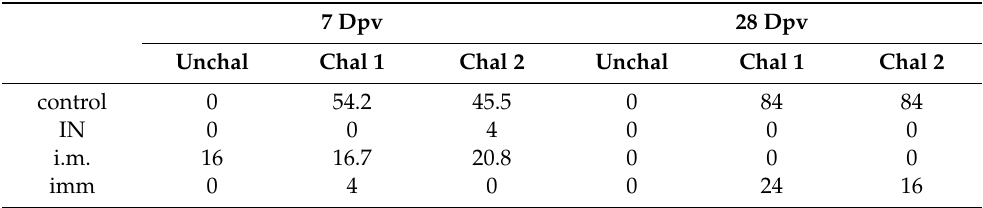
Table 2. Percent (%) cumulative mortality for each treatment group.